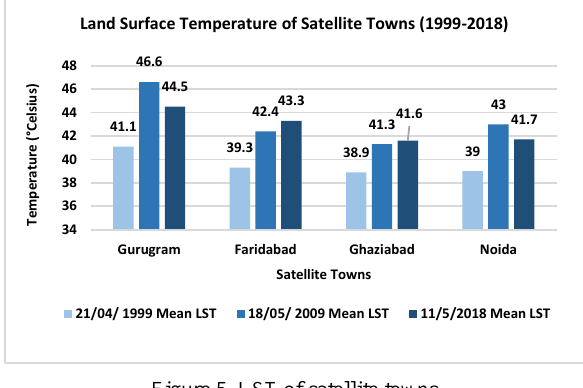
Figure 5. LST of satellite